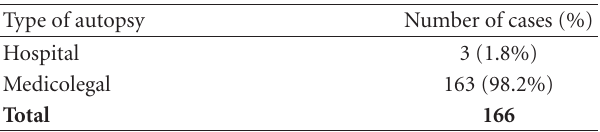
Table 1: Comparison of hospital (clinical) and medicolegal autop- sies.